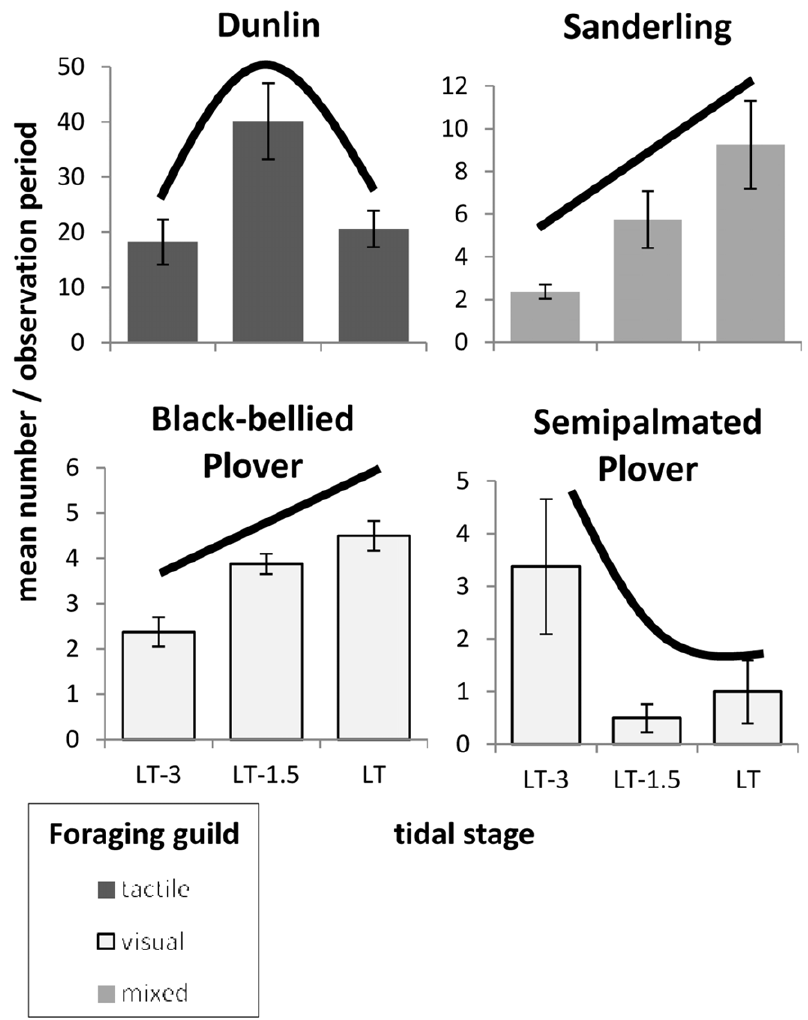
Figure 7. Trends in abundance of commonly observed shorebird species: by tidal stage. All flats combined.